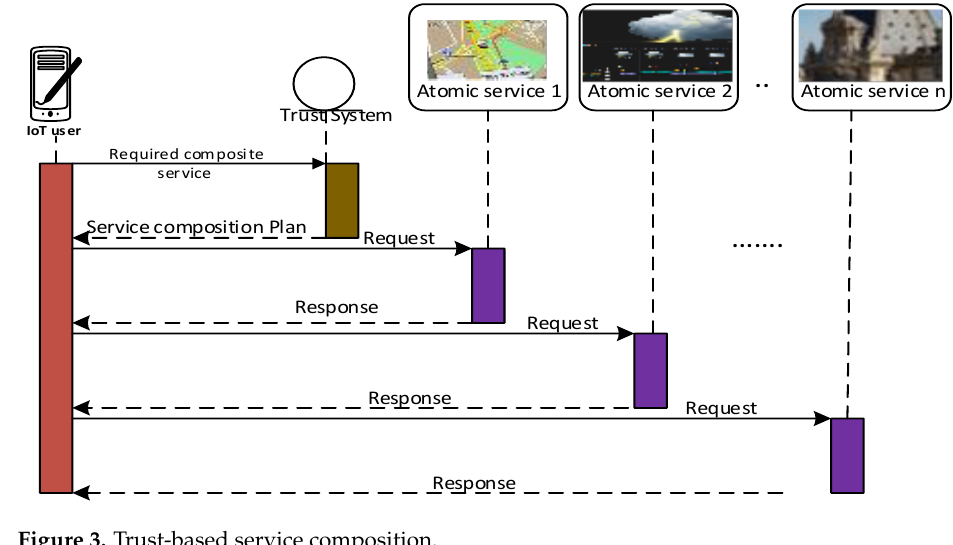
Figure 3. Trust-based service composition.